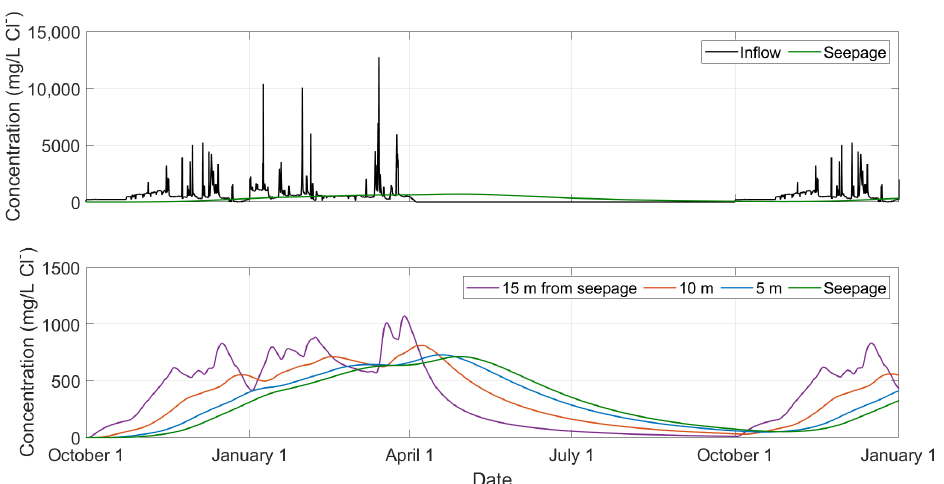
Figure 11. Concentration–time plot from the start of the typical salt season to show the mitigation of salt from the inflow to the seepage face. The top panel plots the inflow (black line) and seepage face (dark green line) salinities. The bottom panel plots the salinities of the different monitoring wells from the numerical model. Closer to the seepage face, lower salinities can be observed. Water 2021 , 13 , x FOR PEER REVIEW